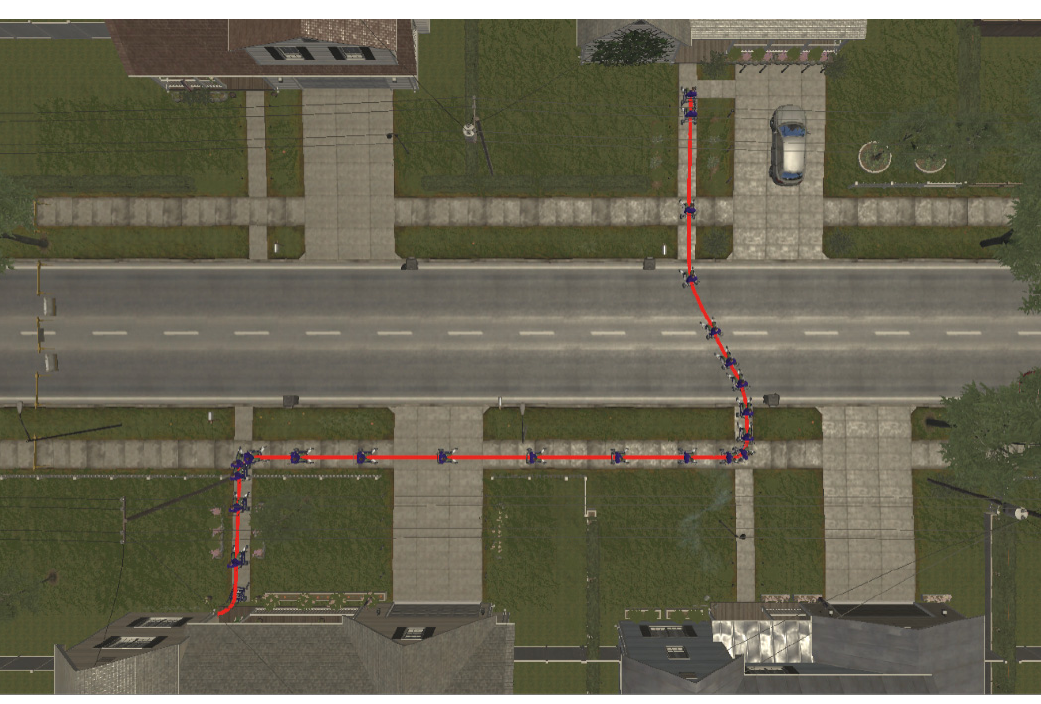
Figure 18. Virtual stroboscopic movement of the robot–human system based on the experimental data.